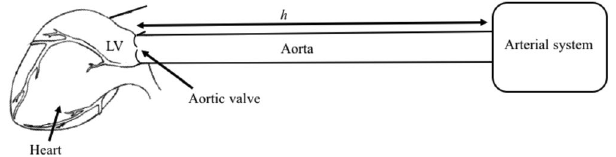
Figure 1. Simplified cardiovascular system model